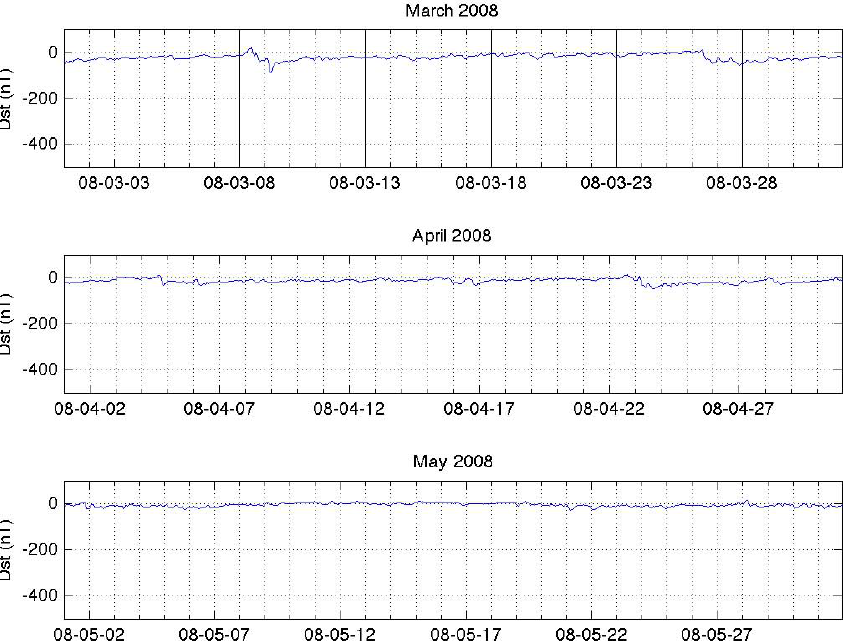
Fig. 4. Variation of Dst for the period 1 March 2008 until 31 May showing the magnetic activity of the magnetosphere for the period around the time of occurrence of the Sichuan earthquake (12 May